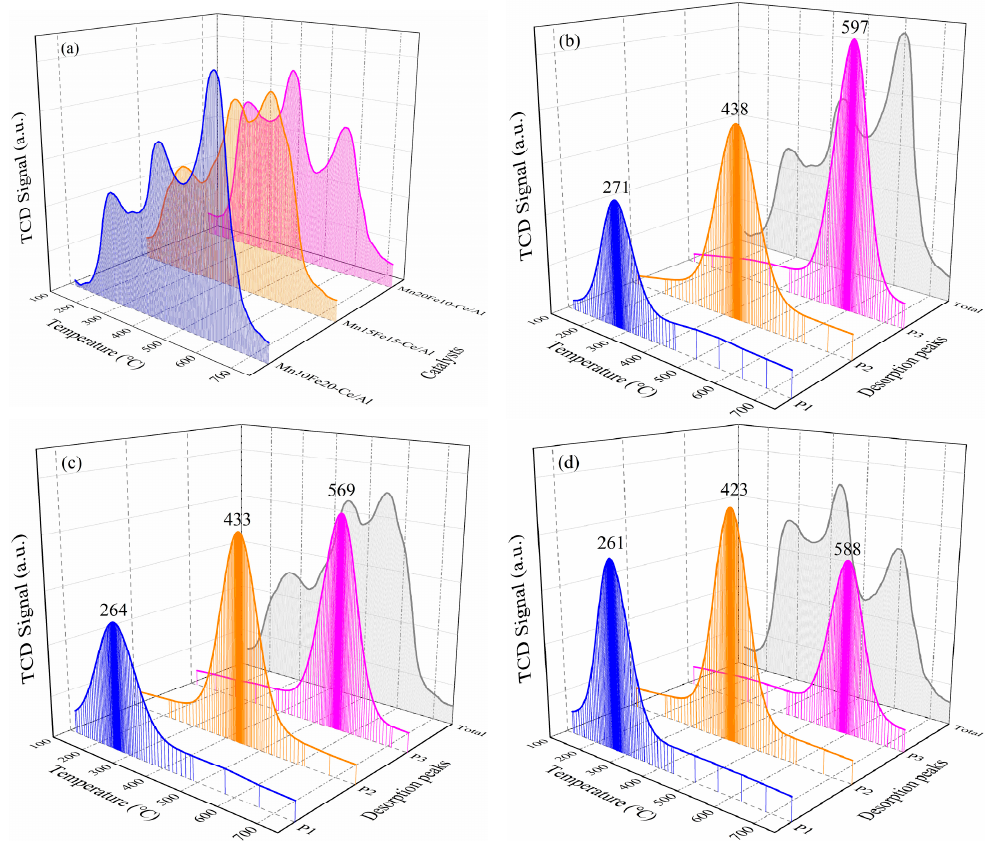
Figure 7. NO ‐ temperature ‐ programmed desorption (NO ‐ TPD) pro fi les of Mn − Fe − Ce − O x / γ‐ Al 2 O 3 Figure 7. NO-temperature-programmed desorption (NO-TPD) profiles of Mn − Fe − Ce − O x / γ - Al 2 O 3 nanocatalysts: ( a ) total NO ‐ TPD curves; ( b) multi ‐ peak Gaussian fi tt ing for Mn10Fe20 − Ce/Al sample; nanocatalysts: ( a ) total NO-TPD curves; ( b ) multi-peak Gaussian fitting for Mn10Fe20 − Ce/Al sample; ( c ) multi ‐ peak Gaussian fi tt ing for Mn15Fe15 − Ce/Al sample; ( d ) multi ‐ peak Gaussian fitting for ( c ) multi-peak Gaussian fitting for Mn15Fe15 − Ce/Al sample; ( d ) multi-peak Gaussian fitting for Mn20Fe10 − Ce/Al sample. Mn20Fe10 − Ce/Al